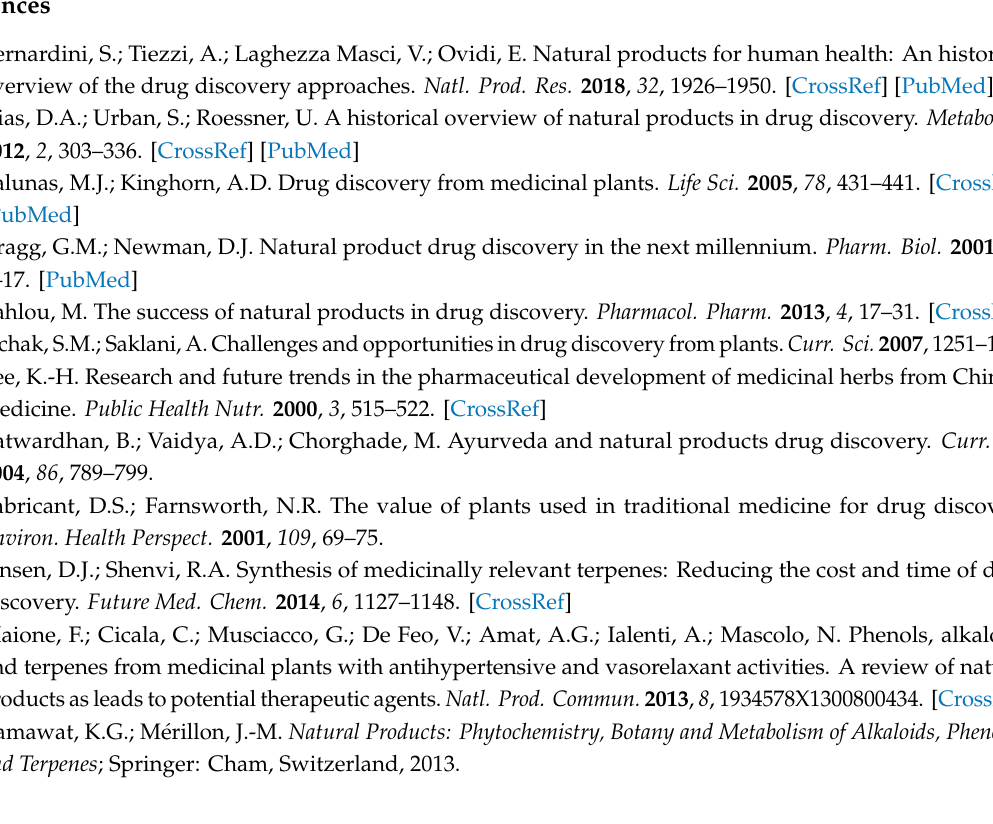
s1, Table S1. Representative images of disk di ff usion assay plates for individual compounds and eutectic blends regarding Staphylococcus aureus (Gram-positive) ATCC 25923. Table S2. Representative images of disk di ff usion assay plates for individual compounds and eutectic blends regarding Staphylococcus aureus (Gram-positive) ATCC 700698 (MRSA). Table S3. Representative images of disk di ff usion assay plates for individual compounds and eutectic blends regarding Staphylococcus epidermis (Gram-positive) ATCC 35984 (MRSE). Table S4. Representative images of disk di ff usion assay plates for individual compounds and eutectic blends regarding Pseudomonas aeruginosa (Gram-negative) ATCC 27853. Table S5. Representative images of disk di ff usion assay plates for individual compounds and eutectic blends regarding Escherichia coli (Gram-negative) ATCC 25922. Table S6. Representative images of disk di ff usion assay plates for individual compounds and eutectic blends regarding Candida albicans (yeast) ATCC 90029. Figure S1. 1H NMR spectra of POH:IBU 1:1. Peak assignment were fully performed. Figure S3. 1H NMR spectra of POH:IBU 2:1. Peak assignment and integration were fully performed. Figure S4. 1H NMR spectra of POH:IBU 3:1. Peak assignment and integration were fully performed. Figure S5. NOESY spectra of THEDES (A) POH:IBU 4:1, (B) POH:IBU 6:1 and (C) POH:IBU